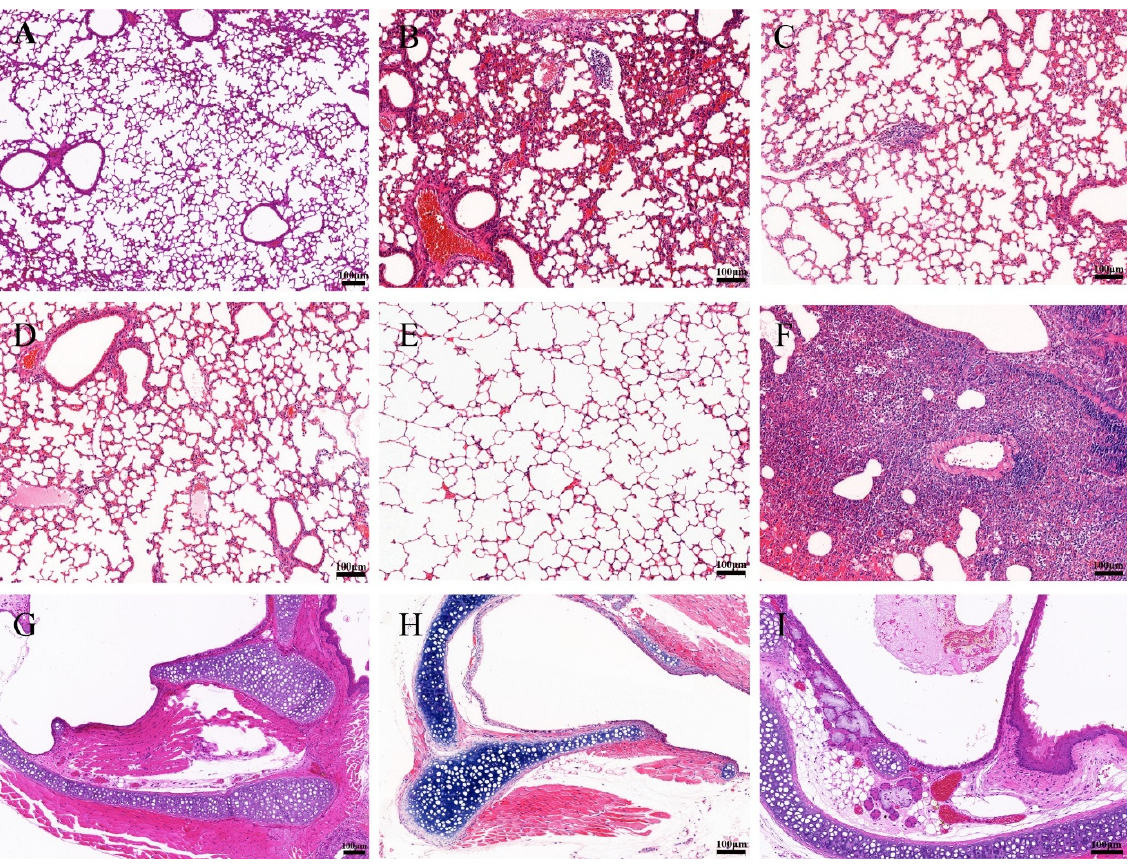
Figure 6. Histopathologic examination of lung and trachea lesions in mice at sixth day